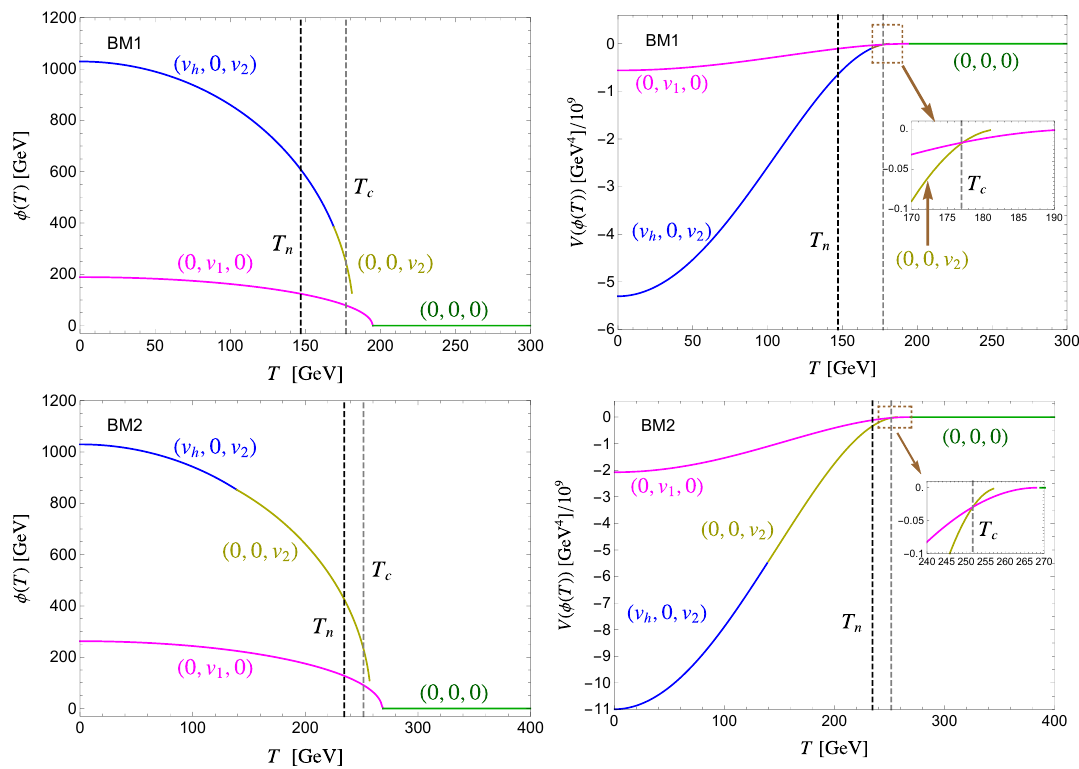
p v 2 + v 2 + v 2 , left) as a function of the temperature 1 2 h